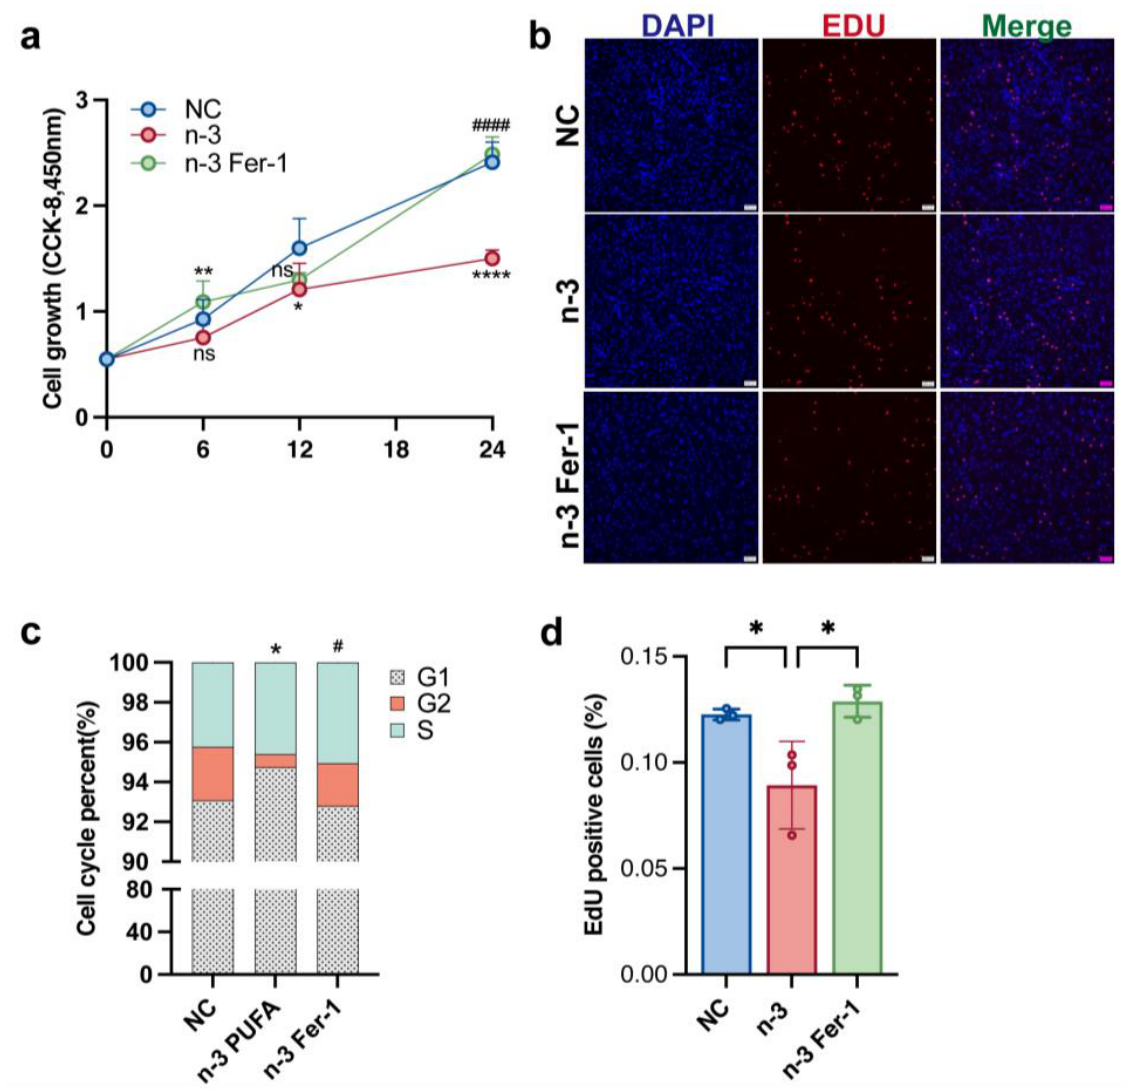
Figure 3. After the medium of KGN cell were added n -3 PUFA the CCK-8 assay, EdU assay were used to determine cell proliferation. The addition of n -3 PUFA significantly inhibited the proliferation of KGN cells, on the contrary, the addition of ferroptosis inhibitor Fer-1 significantly restored the proliferation ability of KGN cells. The result of CCK-8 ( a ) is consistent with the result of EDU experiment ( b ), and ( d ) is the statistical result of EDU experiment. After KGN cells were treated with n -3 PUFA, the results of flow cytometry showed that the number of cells in the G2 phase was significantly reduced, suggesting that n -3 PUFA inhibited cell proliferation ( c ). Data are means ± SD (n = 3). * p < 0.05, ** p < 0.01, **** p < 0.0001 , # p < 0.05,#### p < 0.0001. ns represents no significant difference.